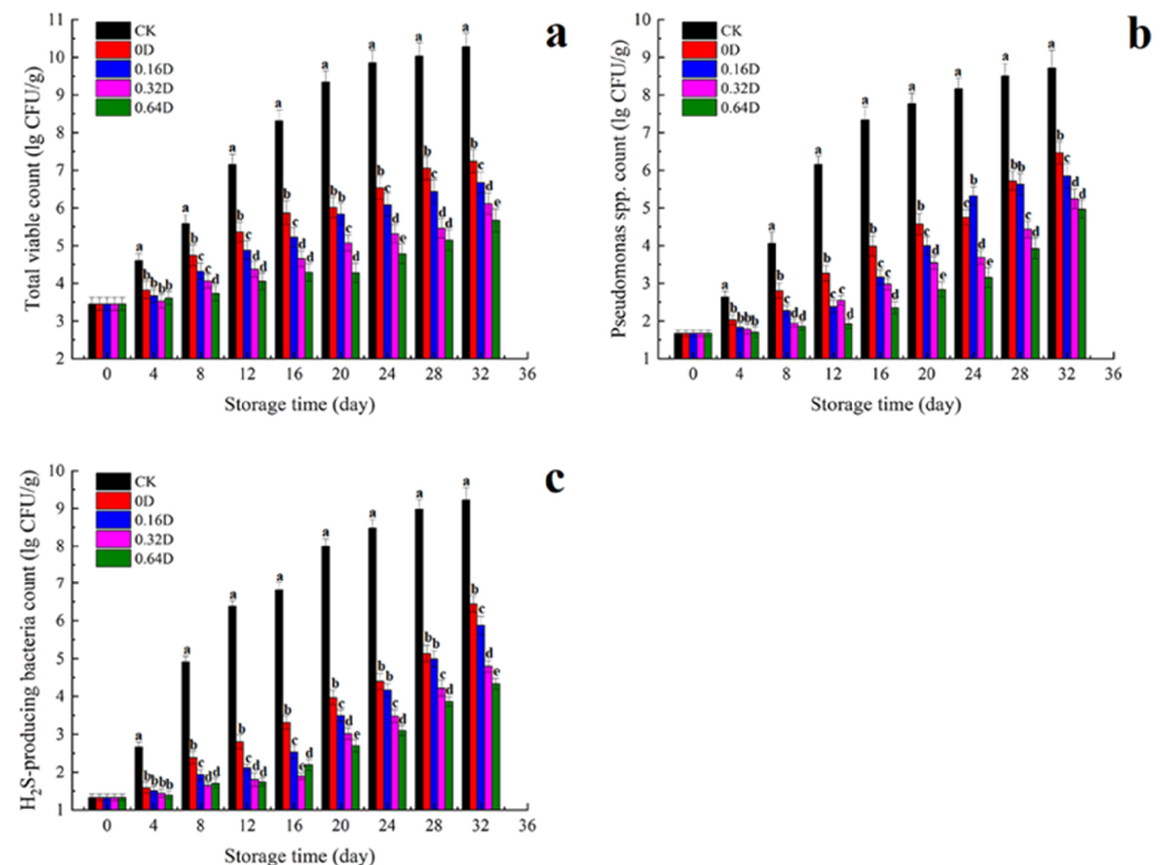
Figure 1. Changes in TVC ( a ), Pseudomonas spp. counts ( b ), and H2S-producing bacteria counts ( c ) of turbots during refrigerated storage. Different superscript letters a–e indicate significant differences ( p < 0.05) .